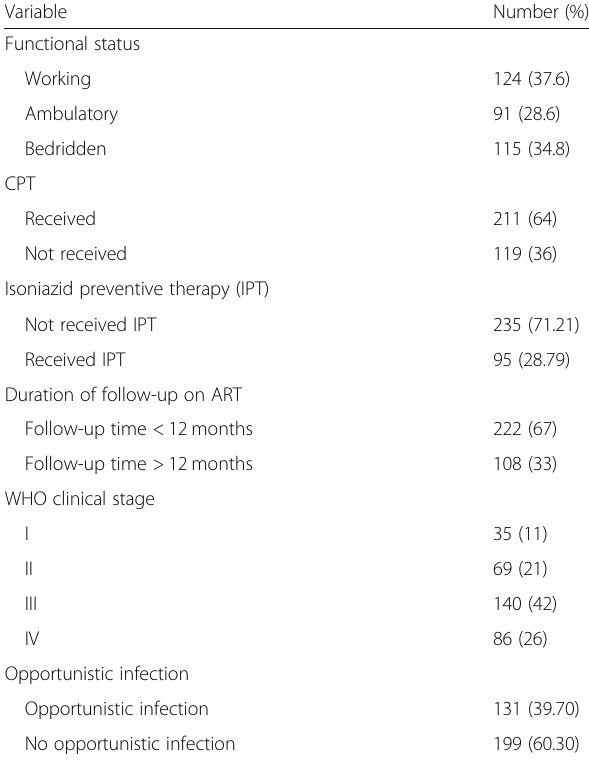
Table 2 Baseline clinical and related characteristics of patients included in the